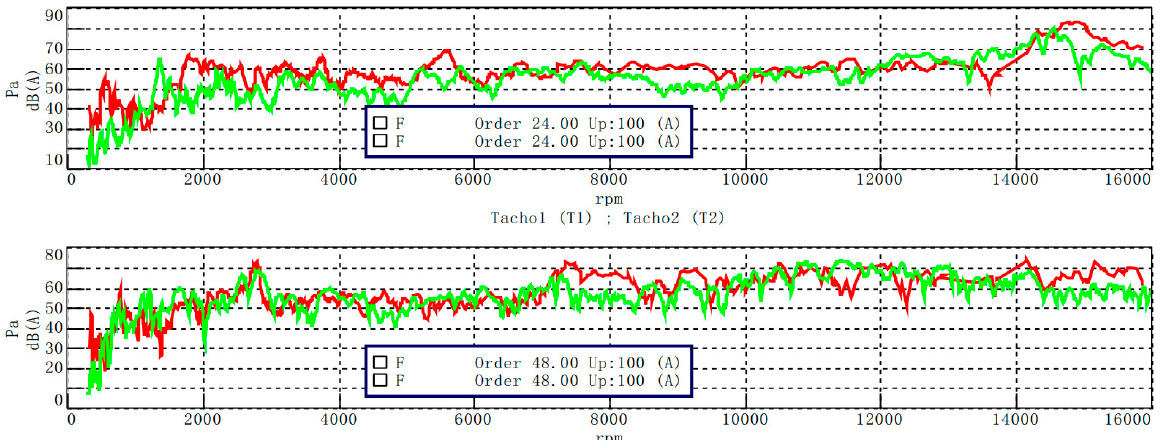
Figure 16. Motor noise tested at 50% maximum